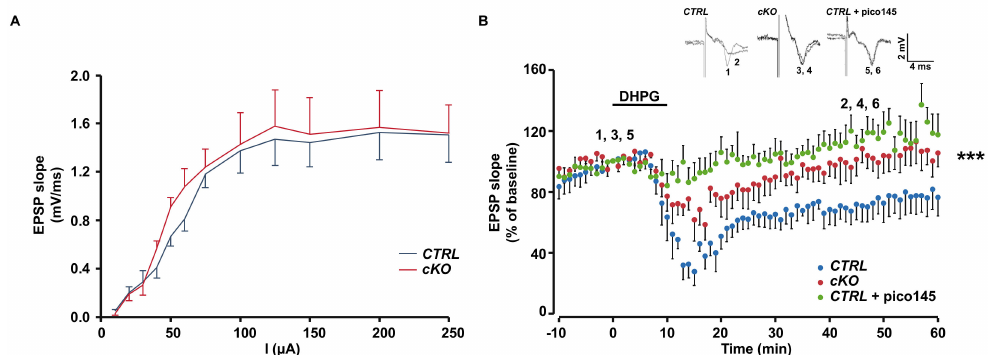
Figure 4. Dihydroxyphenylglycine- (DHPG) induced long-term depression (LTD). A . The input–output relationship between field excitatory postsynaptic potentials (fEPSP) measured in CA1 stratum radiatum and the intensity of stimulation in brain slices from CTRL mice (blue lines) and cKO mice (red lines), both injected with tamoxifen. B . Time-course of fEPSP slopes (mean ± SEM) measured before and after stimulation with 50 µ M DHPG. CTRL brain slices (blue dots), cKO slices (red dots), and CTRL slices treated with 1 nM pico145 (green dots). Upper insets show representative traces of fEPSP before and 40 min after DHPG. ***: p < 0.001, one-way repeated measures ANOVA followed by Bonferroni test, n = 5 for each